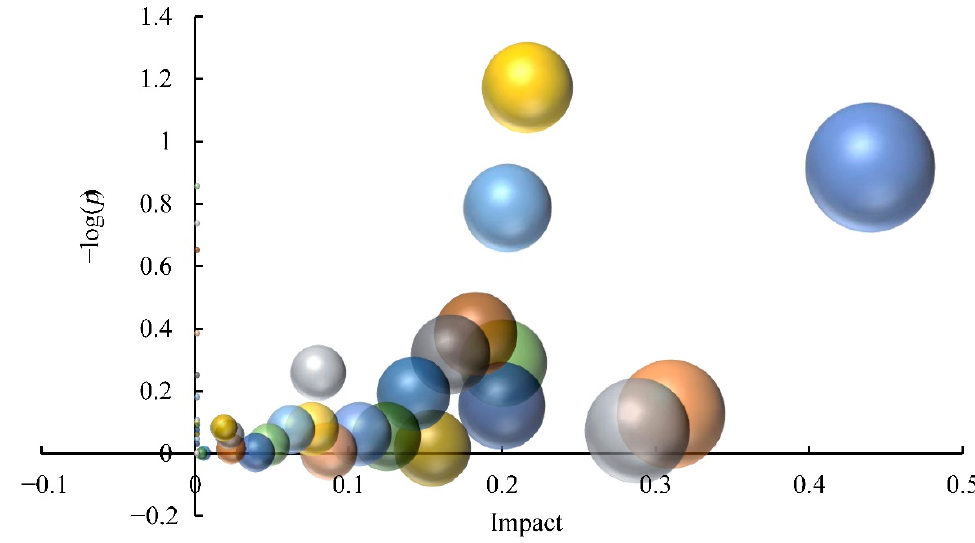
Figure 2. Influence of differential metabolites on the metabolic pathways of distinct C. album cultivars. Each dot represents a metabolic pathway. Ordinate values indicate the significance of metabolites enriched in this pathway, with higher values reflecting greater significance levels. The abscissa indicates the influence level of DAMs on the metabolic pathway; the values and dots of highly influenced metabolic pathways are larger.